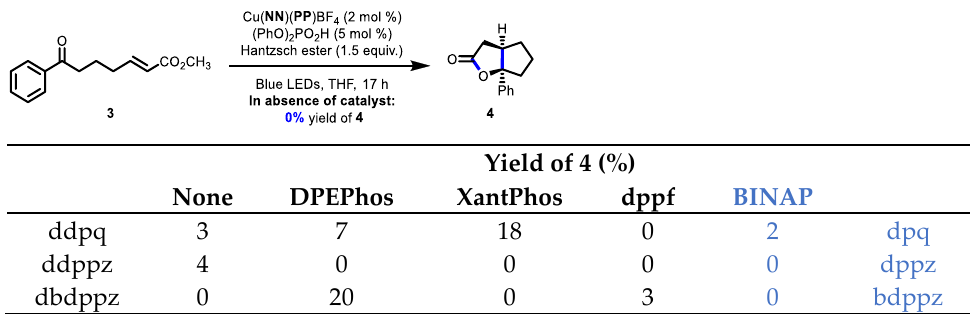
Figure 5. Comparison of the BINAP -containing copper complexes bearing π -extended ligands in a photochemical PCET process.